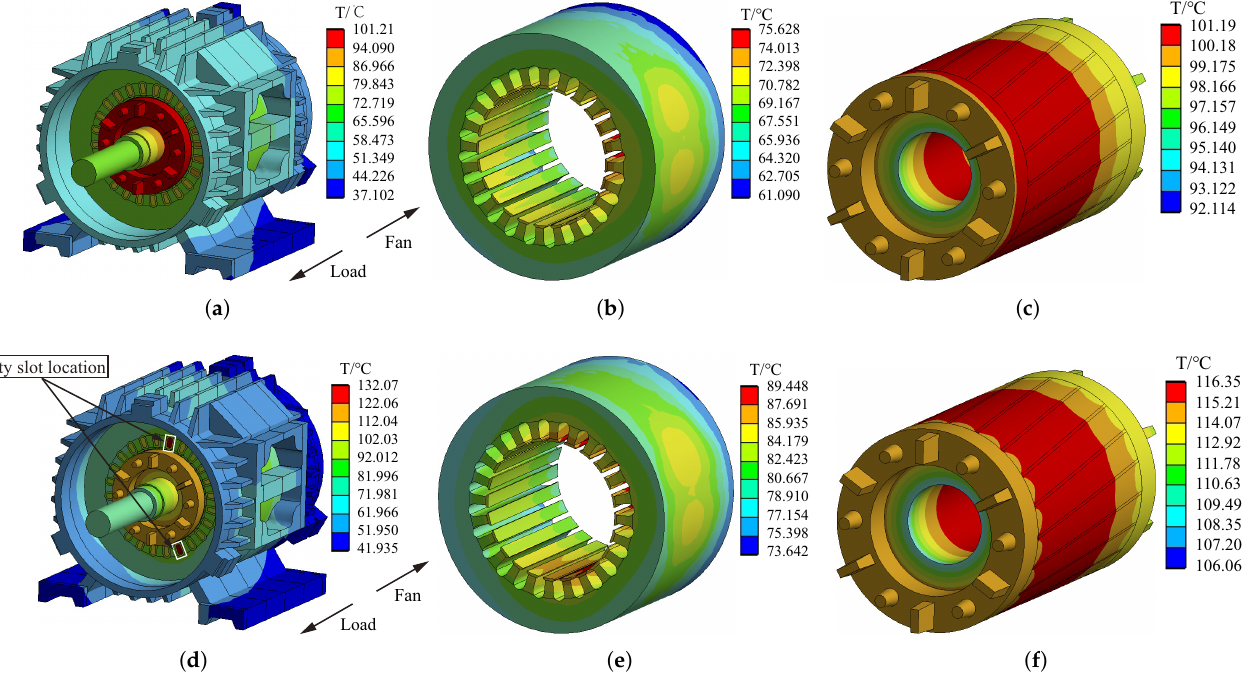
Figure 8. Temperature distributions of normal and faulty motor. ( a ) Normal motor. ( b ) Normal stator core. ( c ) Normal rotor. ( d ) Faulty motor. ( e ) Faulty stator core. ( f ) Faulty